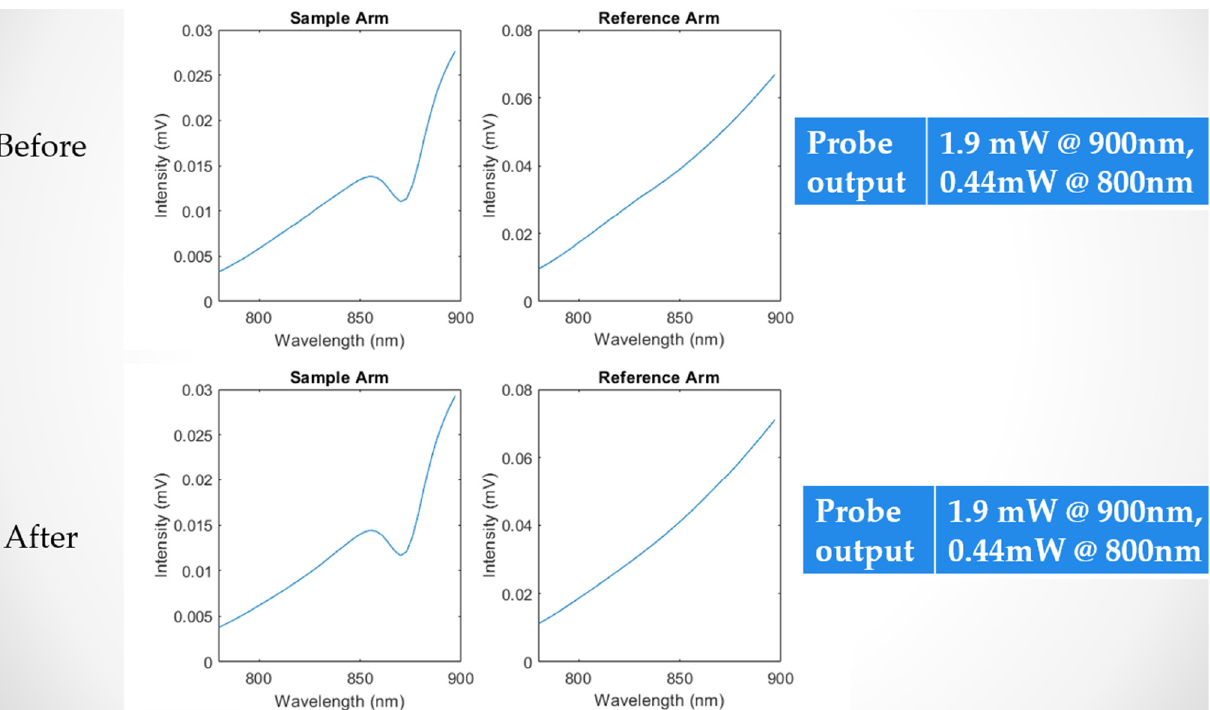
Figure 25. Spectrum and power comparison before and after moving within building (rolling on brick floor).